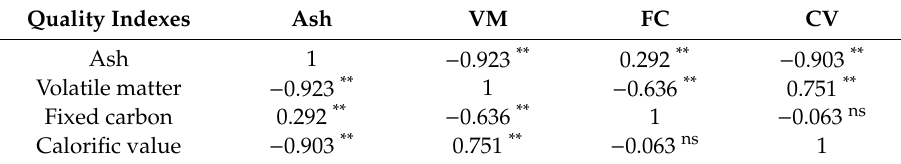
Table 2. Pearson’s correlation coe ffi cients of four quality indexes for all